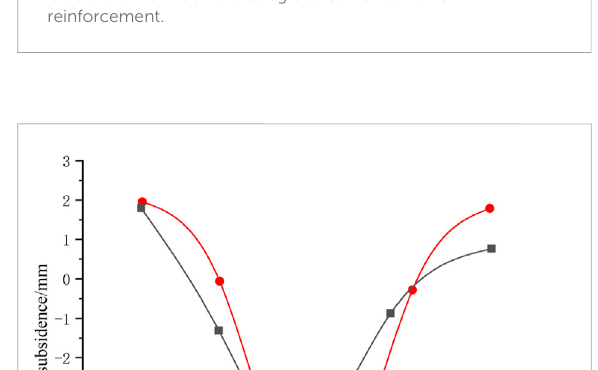
FIGURE 17 Cloud chart of track and subgrade settlement after reinforcement.